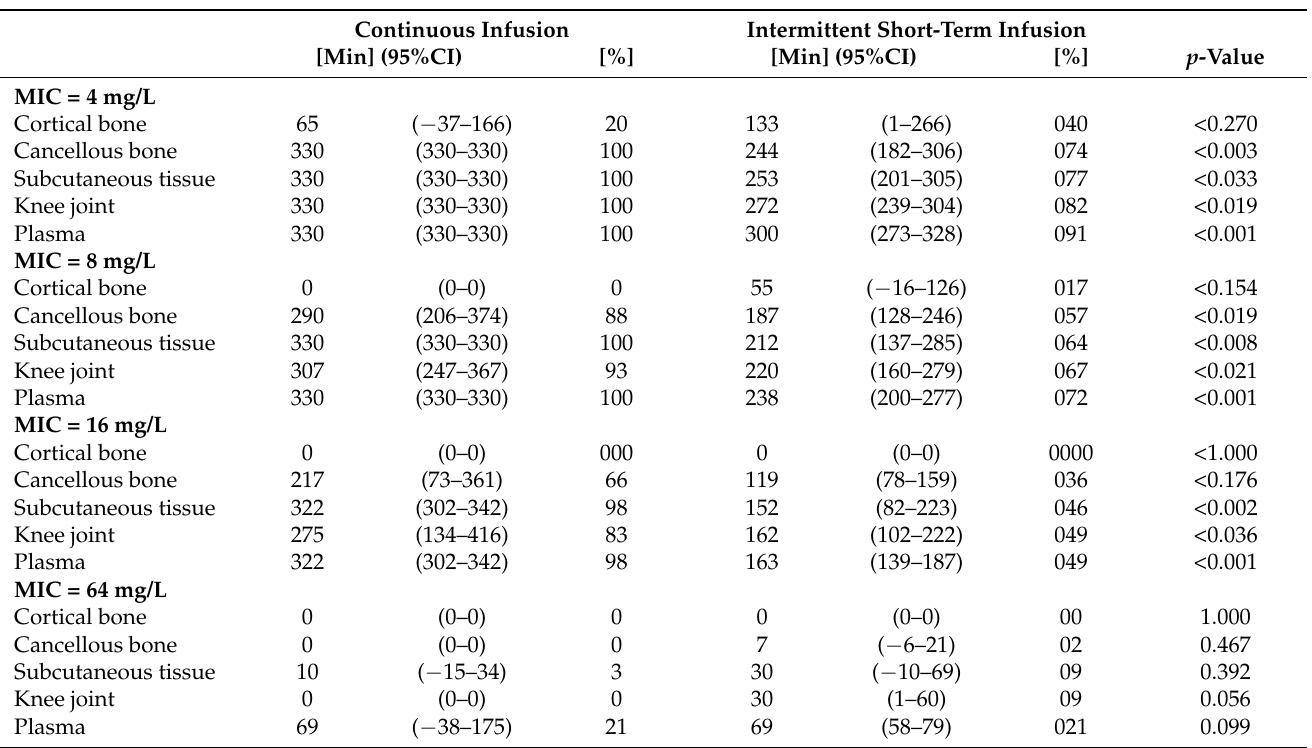
Table 1. Mean time the free piperacillin concentration was above the minimum inhibitory concentra- tion ( f T > MIC) in the third dosing interval. T total = 330 min.